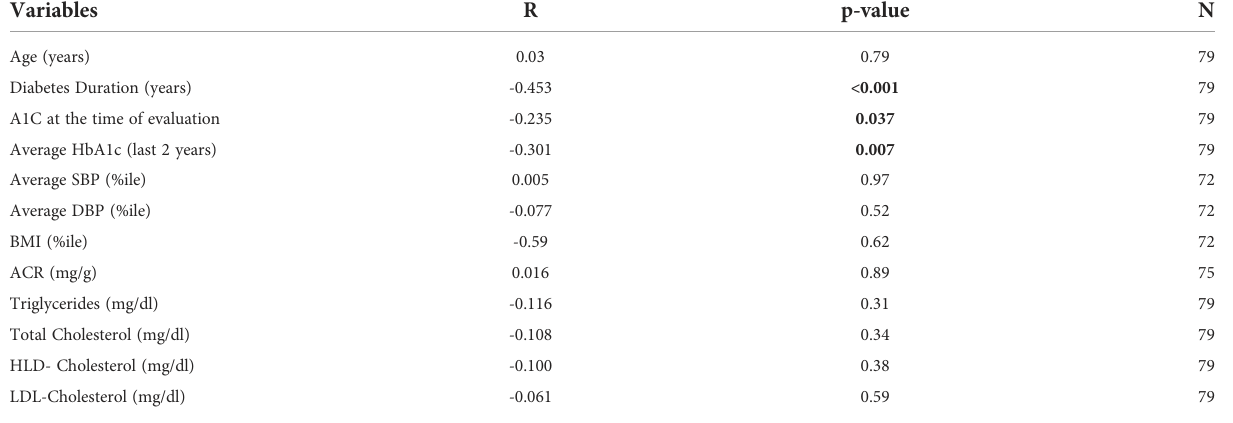
TABLE 2 Correlations between KL and other independent variables.